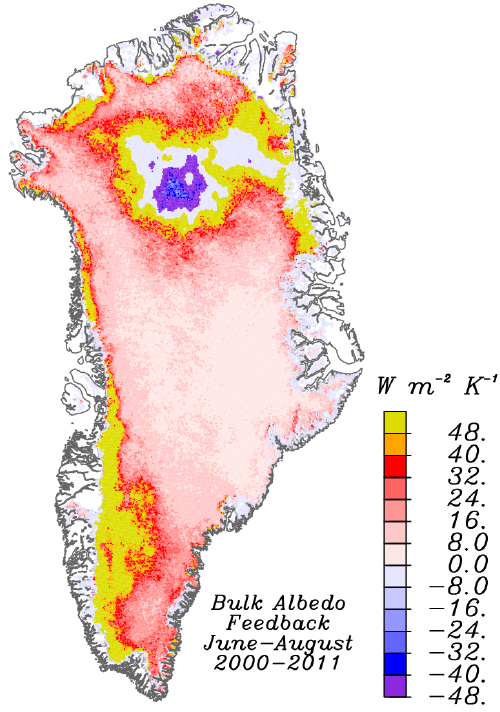
Fig. 12. Summer (JJA) spatial patterns of bulk albedo feed- back defined by the temporal trend in 1S net / 1T air using MODIS MOD10A1 albedo data and calibrated MAR simulations of S ↓ and T air